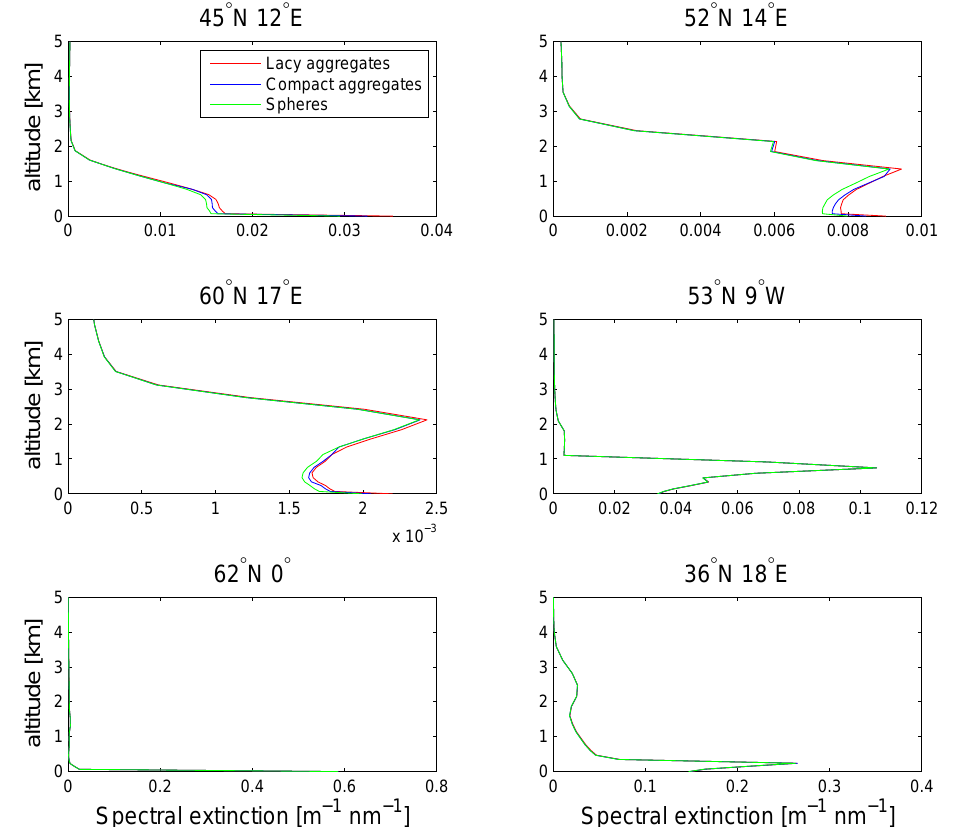
Fig. 4. Vertical profiles of the spectral extinction at λ = 532nm for six different locations as indicated in the figure headings. Results are based on the lacy aggregate (red), compact aggregate (blue), and homogeneous sphere models